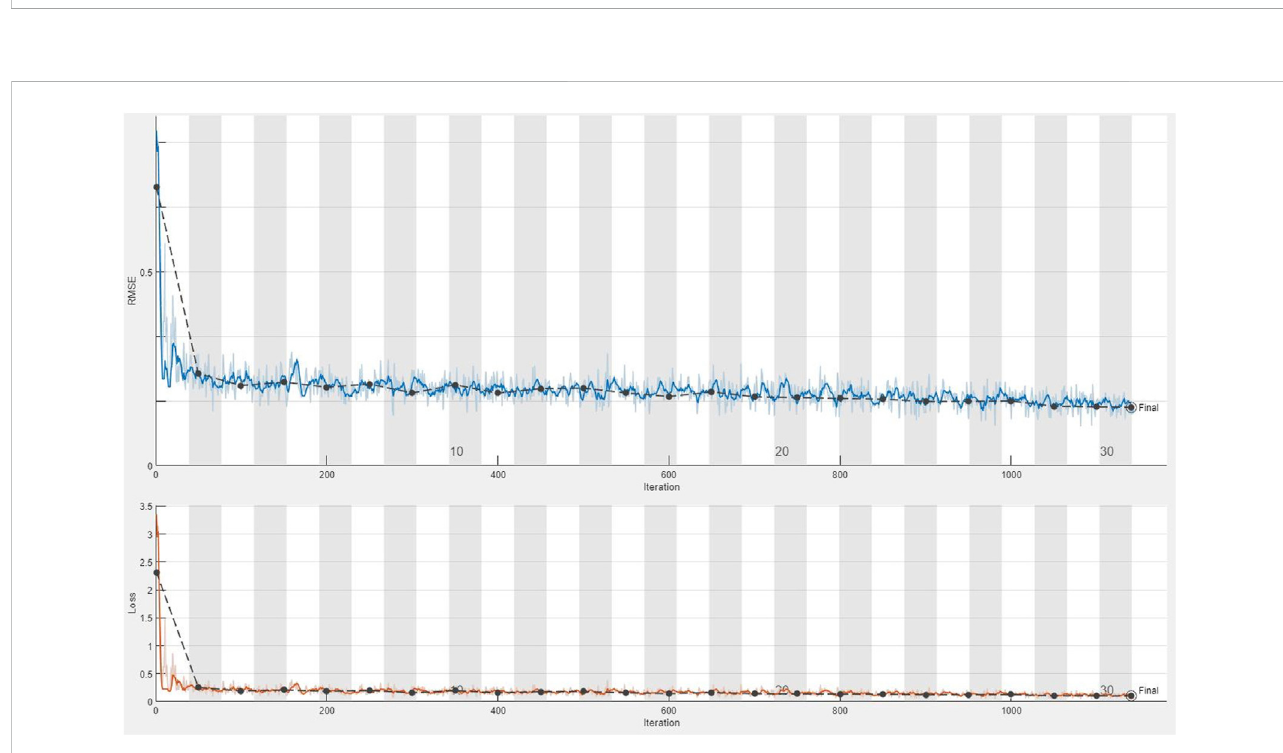
FIGURE 6 Plot of the fi fth training of the dataset applying the CDL network for calculating the loss value and RMSE parameter from the second group of geochemical indicator elements (Ag – Cd).